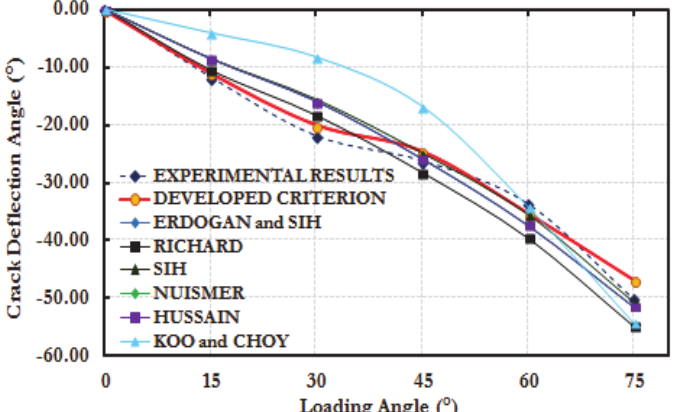
Figure 4: Comparisons of experimental and predicted crack deflection angles -